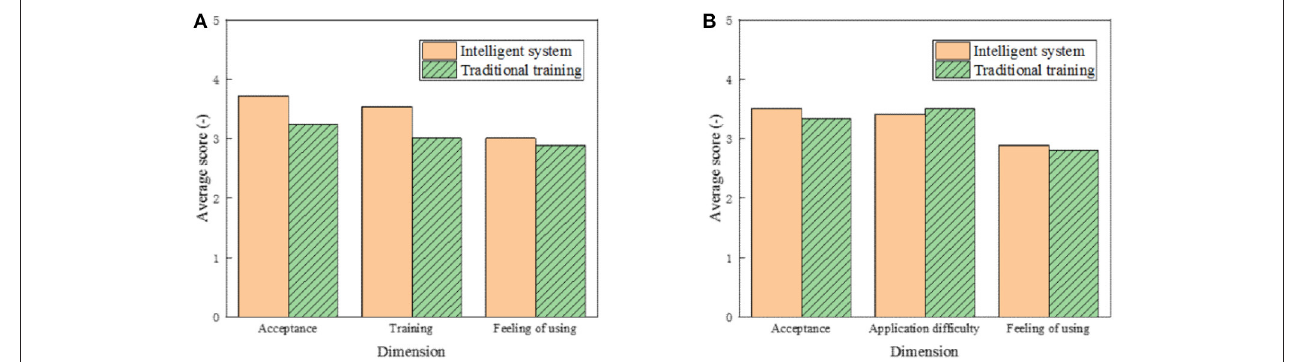
FIGURE 12 | Comparative analysis of training effect of different systems.